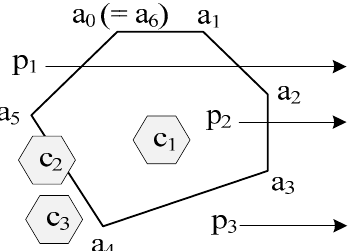
Figure 2. Example of an area, points, and cells. This area is a polygon composed by points a 0 , a 1 , ... , and a 5 . To this area, point p 1 and point p 3 are not-inside and point p 2 is inside, both cells c 1 and c 2 are overlapped and c 3 is not overlapped. Moreover, cell c 1 is also termed as inside this area.